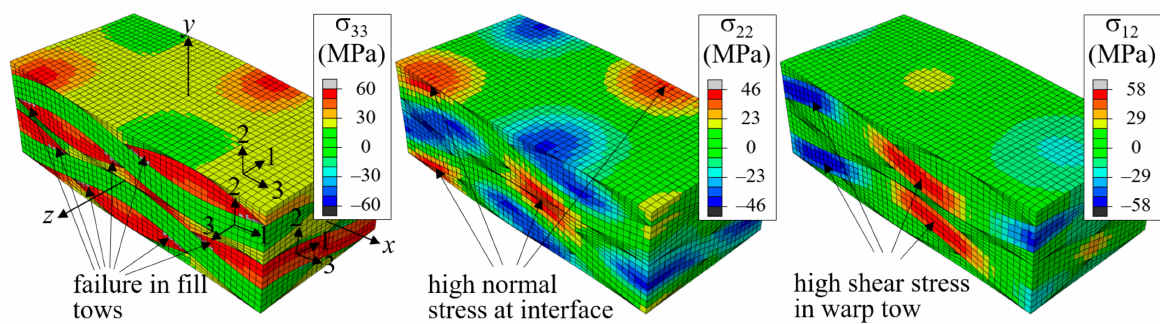
Figure 12. Stress distribution for two-ply shifted unit cell under x -tension at ˆ ε xx = 0.006 (deformation scale factor = 5).